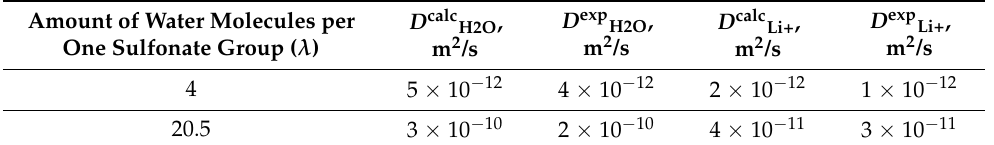
Table 1. Self-diffusion coefficients of water molecule and lithium cation calculated from the 1 H and 7 Li relaxation data ( D calc ) and experimentally measured ( D exp ) [24,25]. Amount of Water Molecules per One Sul-